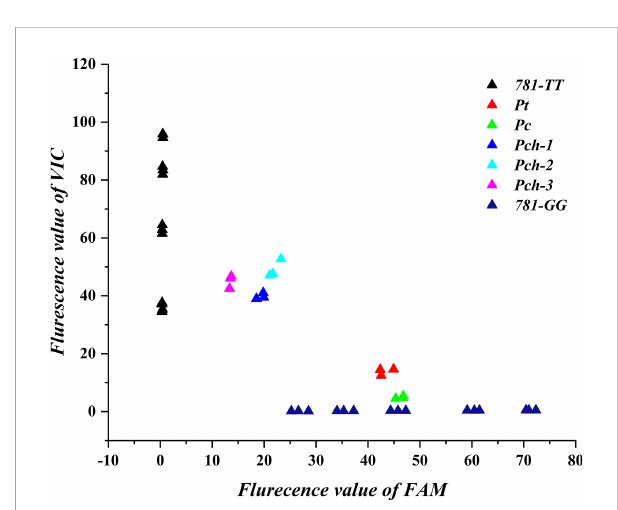
FIGURE 6 Gene copy number analysis of 781- TT and 781- GG in Pulsatilla ceruna, P. chinensis and P. turczaninovii. Pc, Pch , and Pt represent P. ceruna, P. chinensis and P. turczaninovii , respectively. 781- TT and 781- GG represent PchAS and PcAS type gene standard,